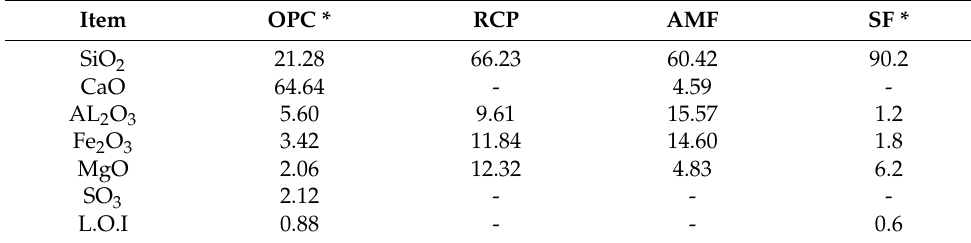
Table 2. The chemical compositions of OPC, RCP, AMF, and SF.